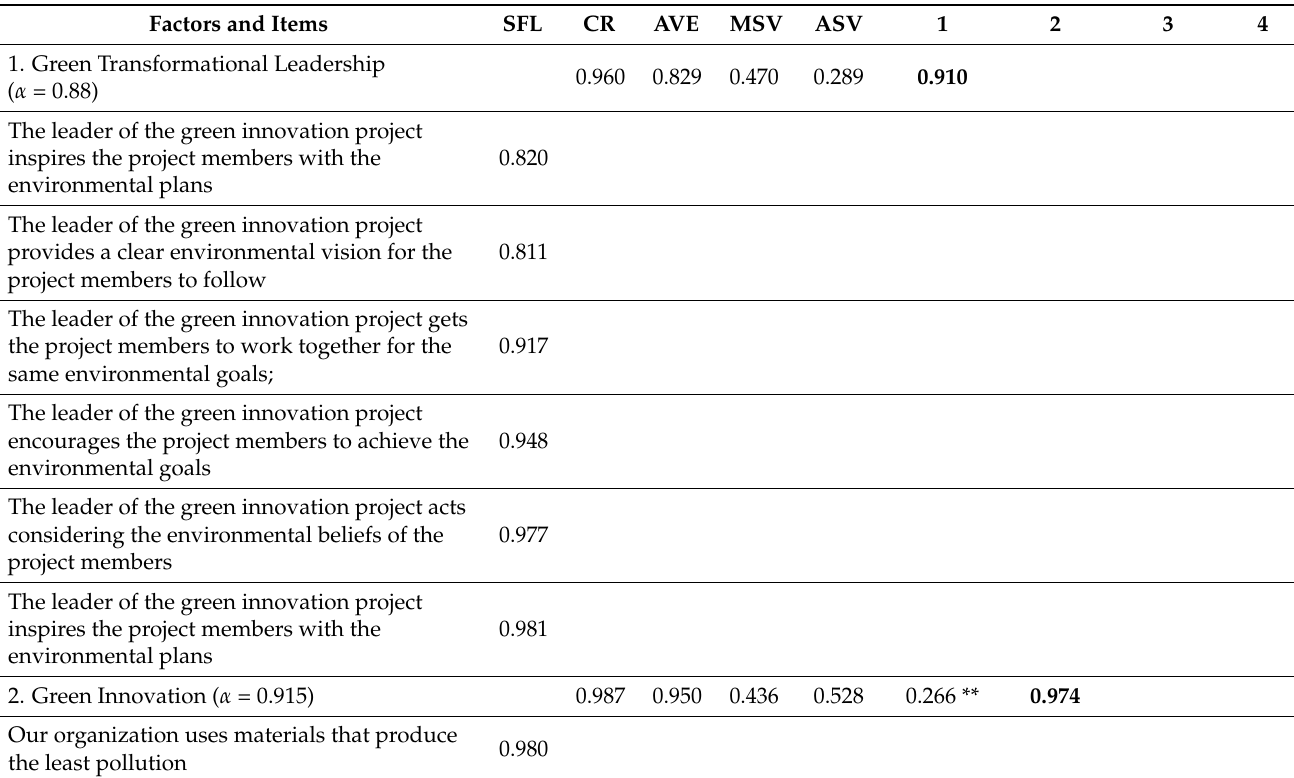
Table 2. Convergent and discriminant validity (developed by the authors using SPSS and AMOS